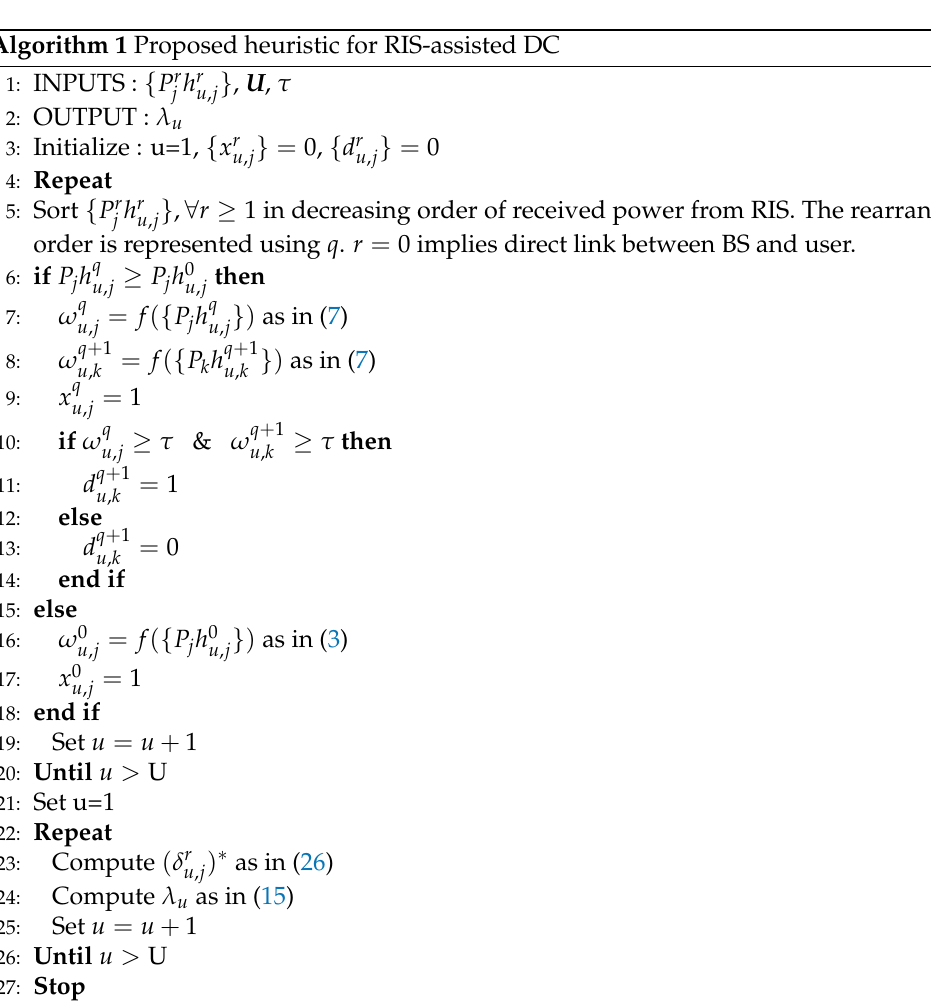
Algorithm 1 Proposed heuristic for RIS-assisted